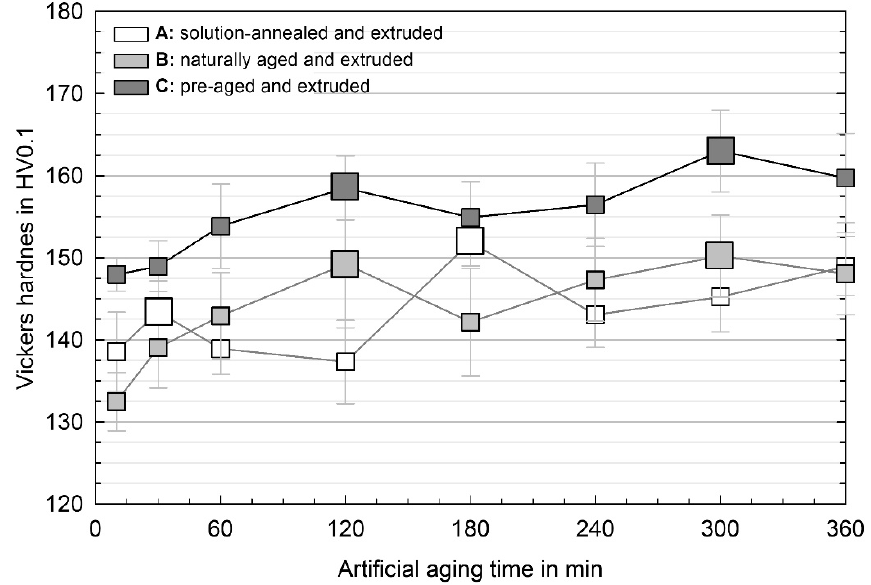
Figure 3. Vickers hardness as a function of the artificial aging time dependent on the processing route. The first and second hardness peak for the investigated maximum aging time is marked for each condition by a larger symbol. By pre-aging prior to linear extrusion, the highest hardness is achieved, when compared to the other processing routes.